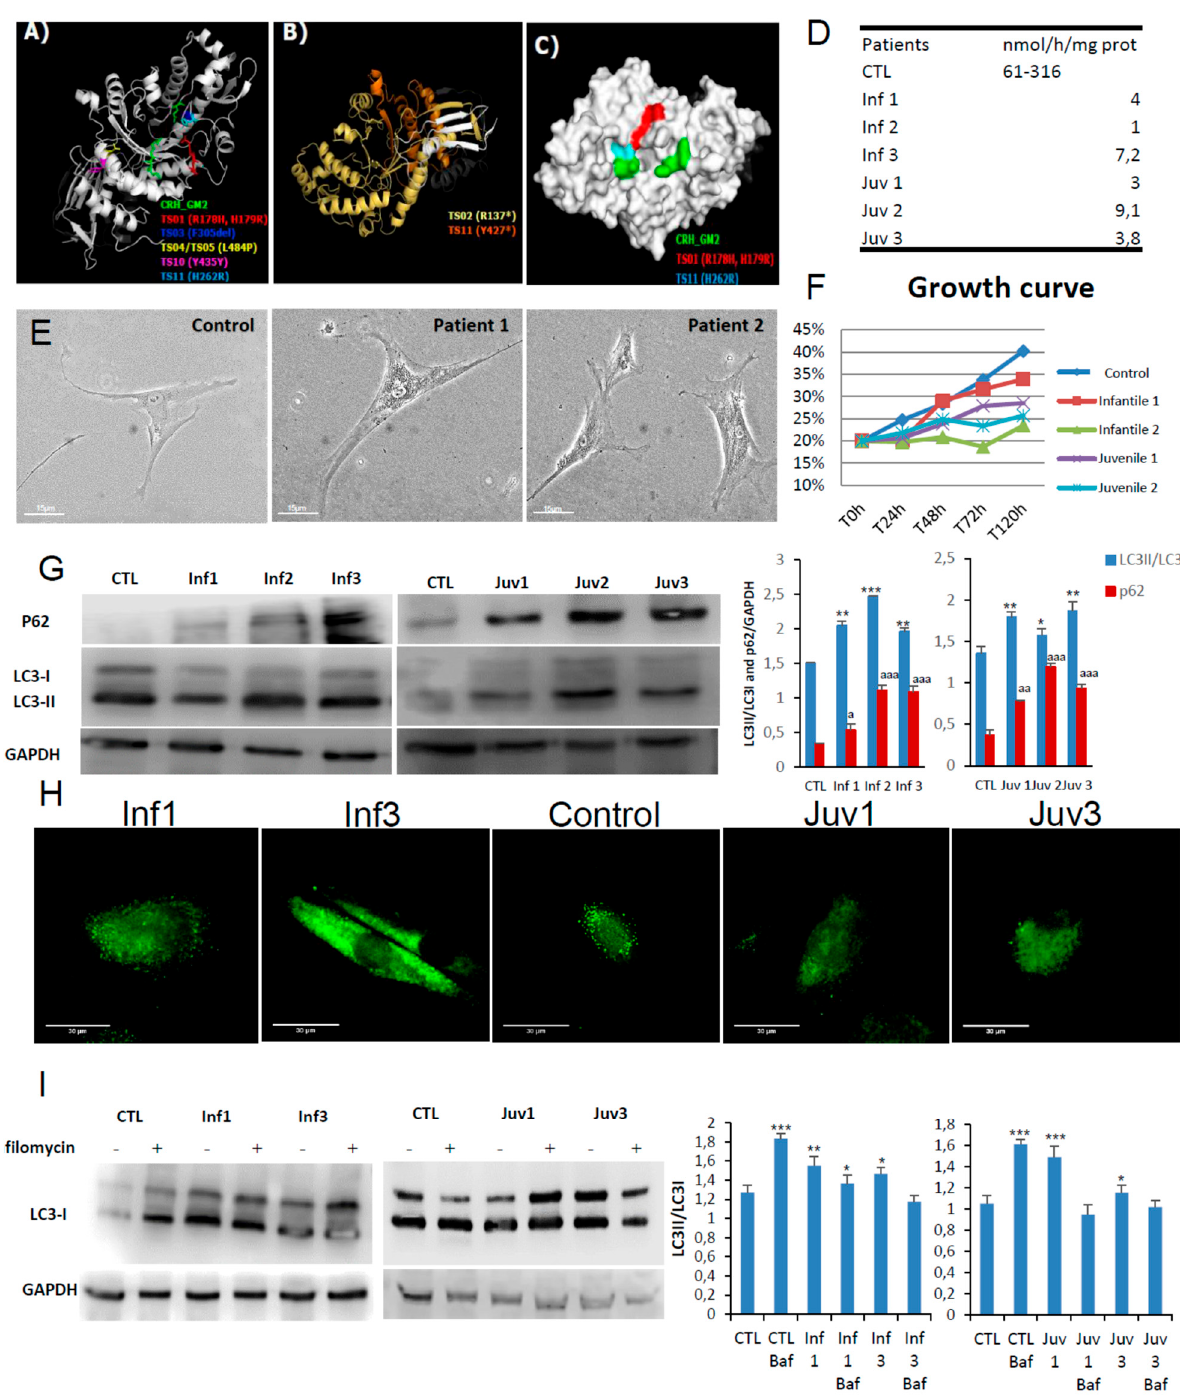
Figure 1. Model structures of HexA (PDB:2GJX) and HexB (PDB:1NOU) sub ‐ unit proteins, highlighting the location of pathogenic mutations. Also shown autophagy in fibroblasts obtained in culture from patients with GM2 gangliosidosis (Tay–Sachs and Sandhoff diseases). ( A ). HexA point mutations: different colours depict amino acid substitutions identified in the cognate structures identified in different mutations studied. ( B ). Frameshift mutations in the alpha subunits found in two patients with Tay–Sachs disease are shown in yellow and orange; premature stop codons are marked by an asterisk. ( C ). The surface of hexosaminidase A with the critical active site region required for hydrolysis of GM2 ganglioside (CRH_GM2). The propeptide is shown in grey and the mature protein chain is depicted in white. ( D ). Enzymatic activity of HexA in fibroblast homogenates. ( E ). Morphological changes in fibroblasts from Tay–Sachs patients compared with control cells. ( F ). Cell growth determined in healthy and Tay–Sachs fibroblasts. ( G ). Expression of autophagy proteins in control and Tay–Sachs fibroblasts: LC3 ‐ I (top panels, top band), LC3 ‐ II (top panels, bottom band). ( H ). Immunofluores ‐ cence staining with anti ‐ p62 antibody. ( I ). Impaired autophagic flux in Tay–Sachs fibroblasts. Determination of LC3 ‐ II in